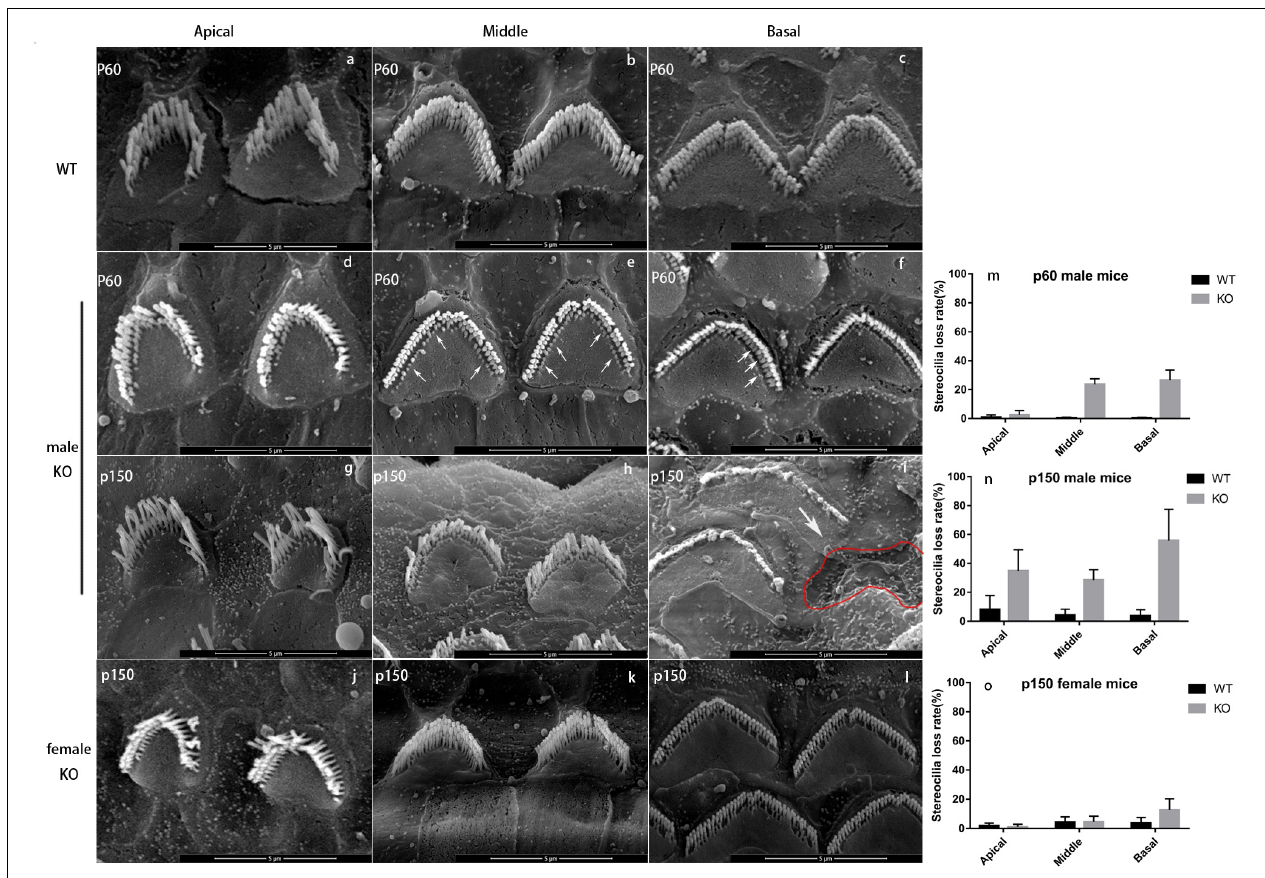
FIGURE 4 | Scanning electron microscope of WT and KO mice. (a-c) OHC bundles of wild-type male mouse at p60. There are three rows of stereocilia (“M” shape) on the cuticular plate (heart shape). Scale bar = 5 nm. (d-f) OHC bundles of Smpx KO male mouse at p60. The loss of shortest row stereocilia from apex to base showed a trend from less to more (arrowed). However, the middle and longest rows were normal, and the “M” shape was still sharp and clear. (g-i) OHC bundles of Smpx KO male mouse at p150. The stereocilia degeneration appeared at the apical turn and the conditions were more severe at the middle and basal turns. The middle and longest rows of OHC stereocilia started to degenerate and the “M” shape was indistinct at the middle turn. The whole bundle degenerated at the basal turn. Some OHCs were dead and left a pit on the basilar membrane (red line). (j-l) OHC bundles of Smpx KO female mouse at p150. The bundles were normal in apical and middle turn. A number of the shortest row stereocilia was degenerated at the basal turn. (m-o) OHC stereocilia loss rate of p60 male mice, p150 male mice, and p150 female mice. This data indicated a progressive OHC stereocilia degeneration and this process was more mild and had a later onset in female